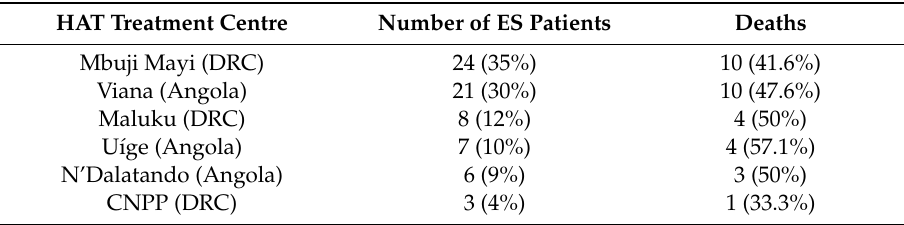
Table 1. Origin and outcome of enrolled ES